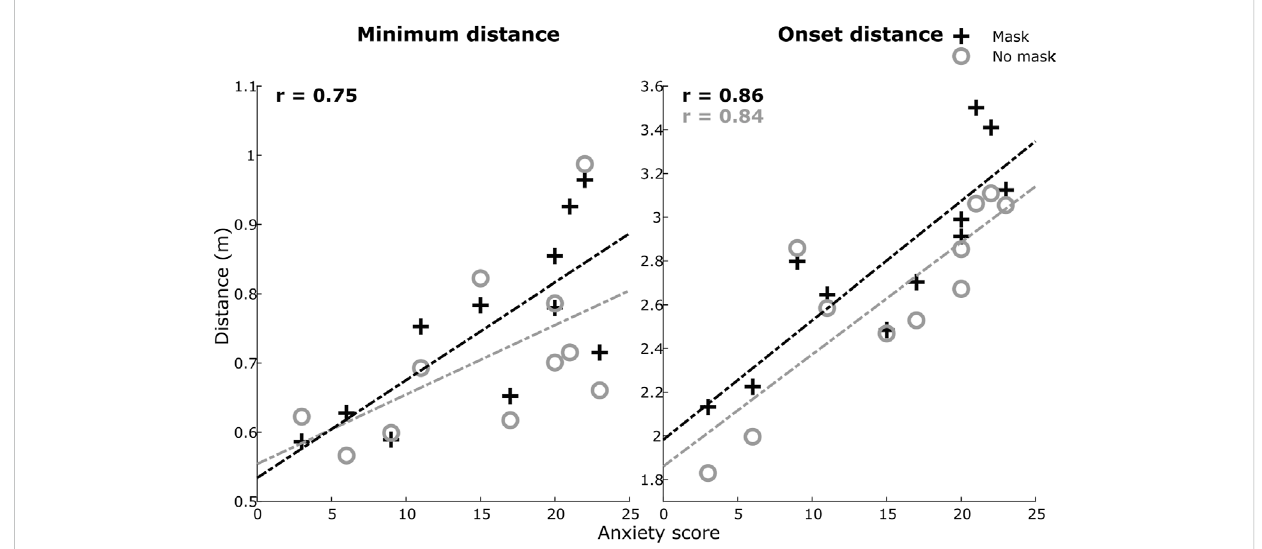
FIGURE 5 Correlations between anxiety score and measures of obstacle clearance. Scatterplots display the relationship between the total Anxiety score (X-axis)andMinimumdistance(LeftsidepanelY-axis),aswellasAnxietyscore(X-axis)andOnsetdistance(RightsidepanelY-axis).Inthisgraph,themean values for Minimum distance and Onset distance were obtained from all trials performed by each participant. Signi fi cant correlations are displayed with the respective correlation coef fi cients (r). A dashed line represents the least squares regression for each